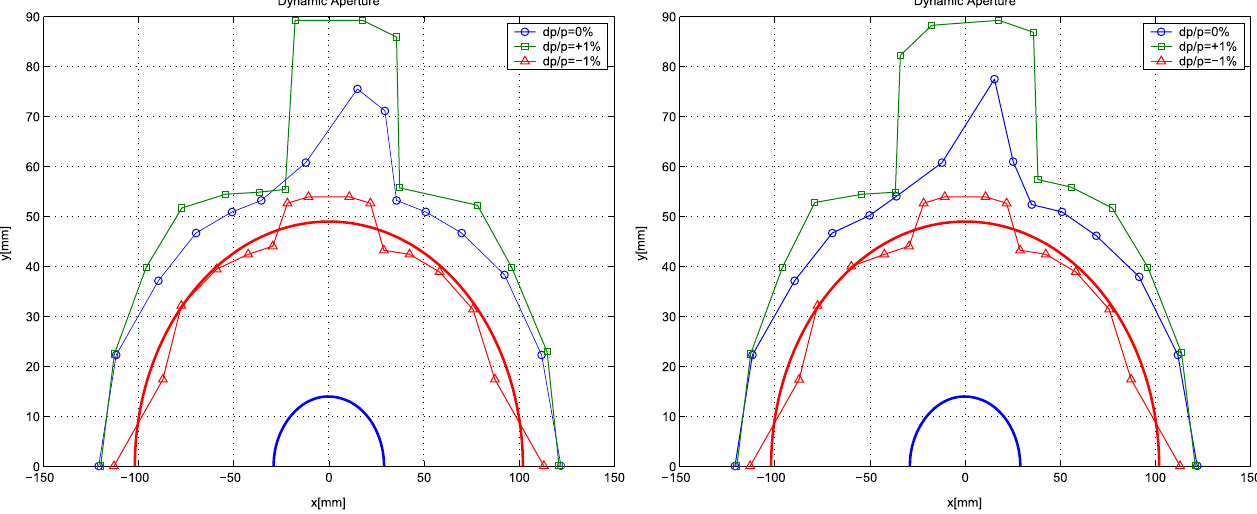
FIG. 8. (Color) Dynamic aperture for the mode with momentum compaction 6 (cid:1) 10 (cid:2) 4 , without errors (left) and with errors (right).